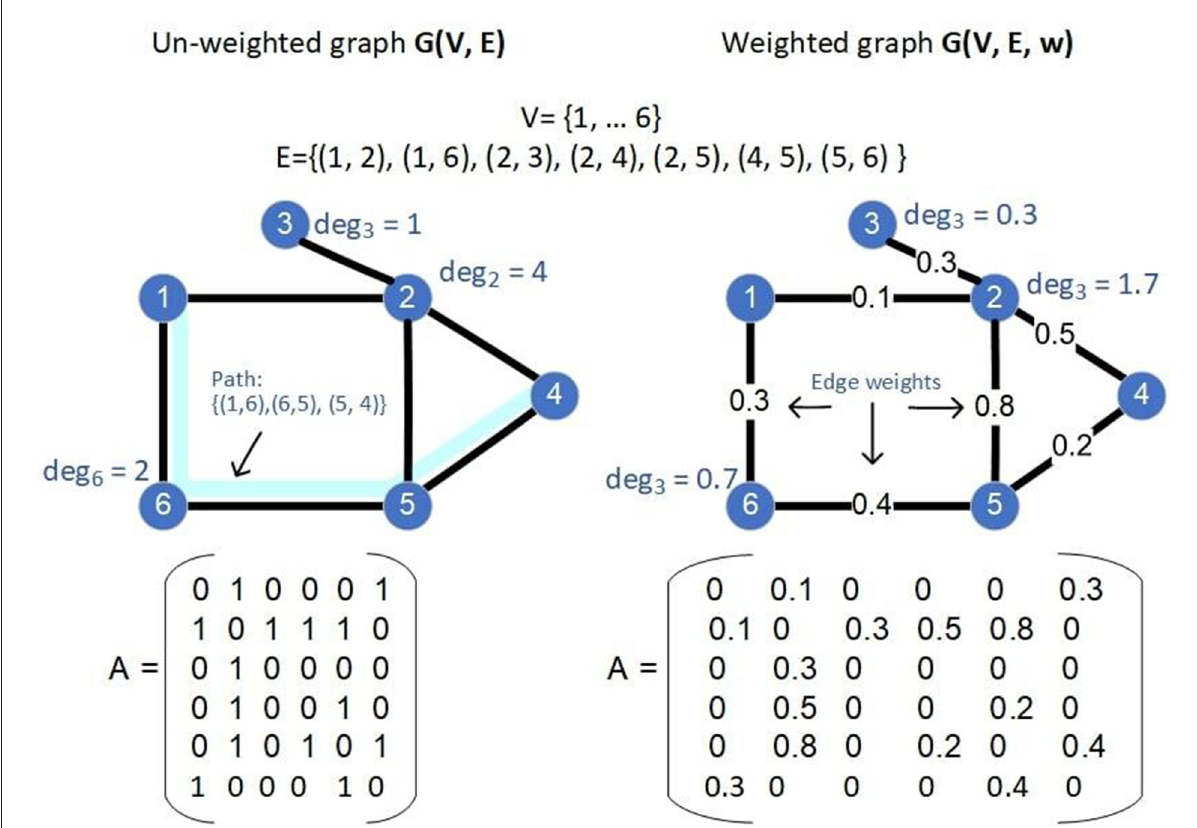
FIGURE1 Two examples of graphs: an un-weighted one (left) and a weighted one (right) , the values of the sets V , E and edge weights (in case of the weighted graph, specified by the function w ), the adjacency matrix A , the degree of some nodes as well as a path (in light blue) are shown in the